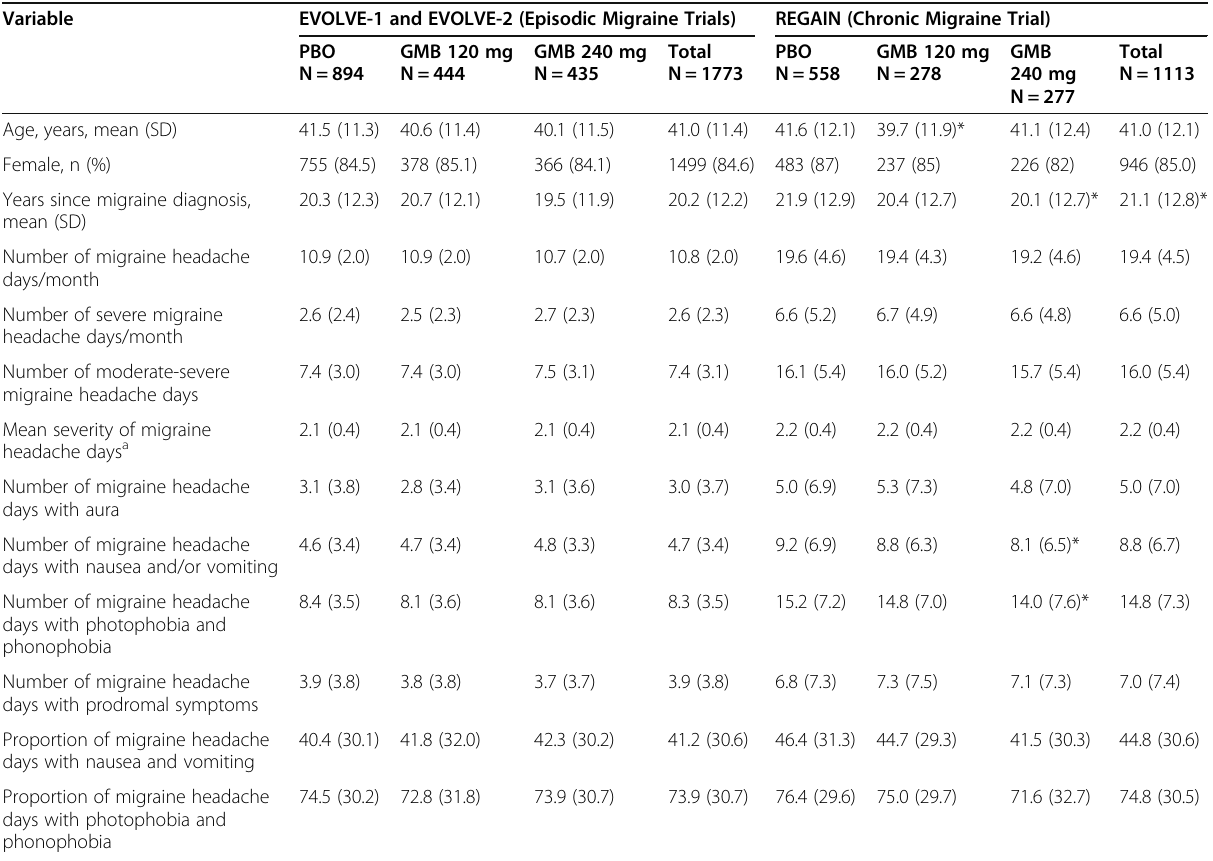
Table 1 Baseline demographics and disease characteristics Variable EVOLVE-1 and EVOLVE-2 (Episodic Migraine Trials)